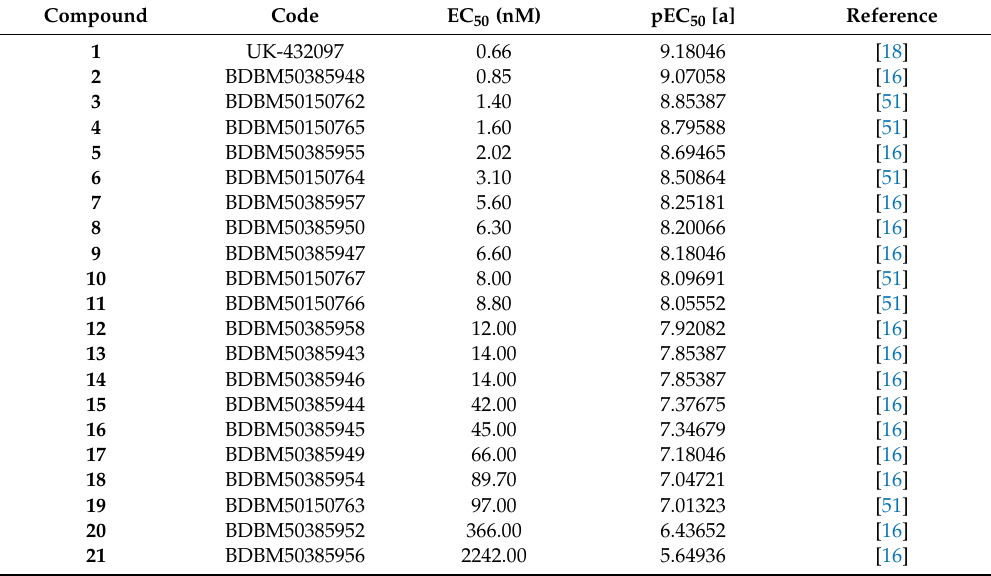
Table 12. Compounds selected, BindingDB codes and their respective biological activity values. Compound